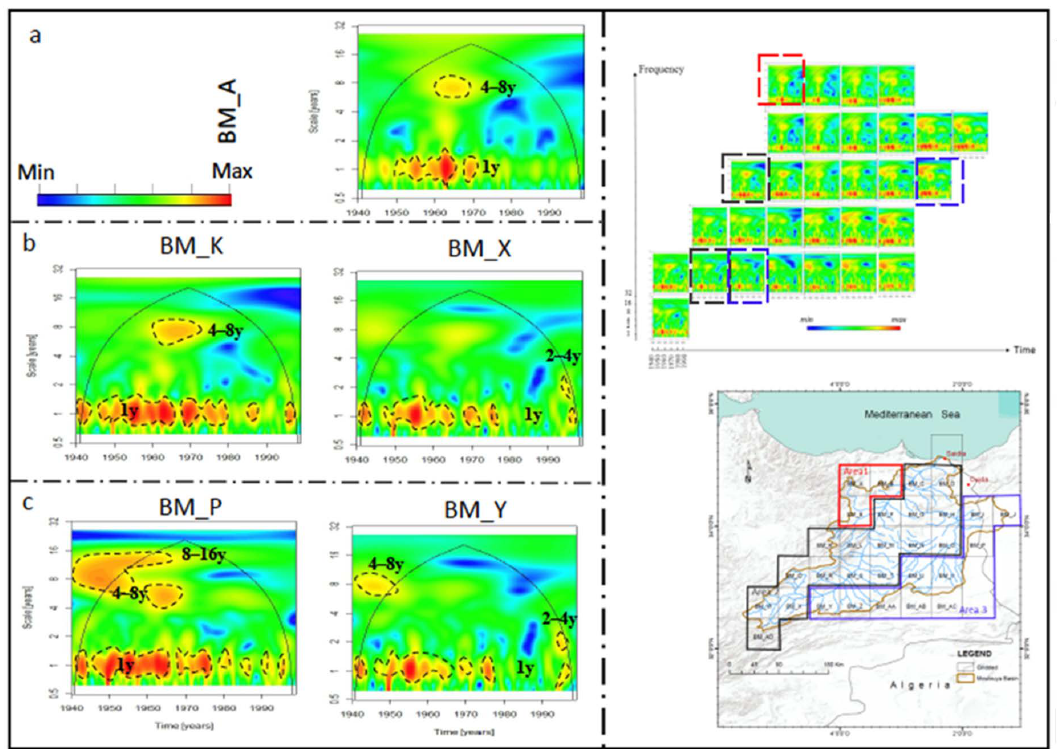
Water 2021 , 13 , x FOR PEER REVIEW Figure 3. Variability of rainfall from SIEREM cells in Moulouya basin is represented for ( a ) area 1, ( b ) area 2, and ( c ) area 3.